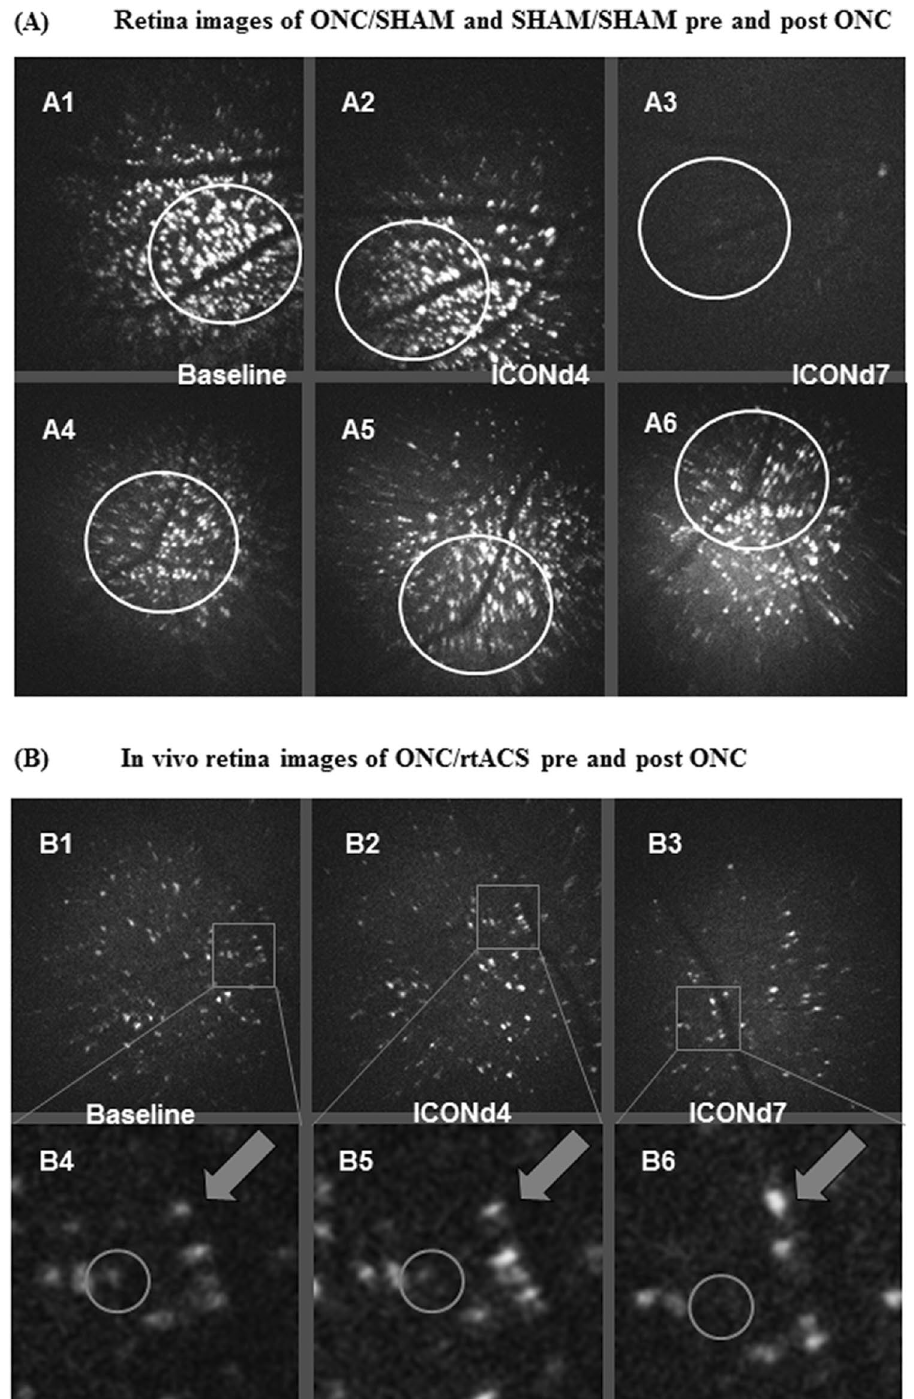
Figure 3. In vivo confocal neuroimaging (ICON) of the retina. These microphotographs demonstrate the in vivo morphological changes of retinal ganglion cells after ONC. In Fig. 3A1–A3 the preserved survival of RGCs on day 4 post ONC (A2) as compared to baseline (A1) is exemplified. The significant cell death in ONC/SHAM animals between day 4 and day 7 can be revealed when matching the images (A2) and (A3). The photomicrographs (A4), (A5) and (A6), showing the ICON results on baseline, day 4 post sham ONC, day 7 post sham ONC, indicate that in unlesioned rats no loss of RGCs developed within this period. The circles outline identical regions imaged at the different time points. Panel B displays the same region of the retina of an ONC/rtACS-treated animal, which was imaged repeatedly at several data acquisition points, i.e. before ONC (baseline; B1, B4), on day 4 (B2, B5) and day 7 post-ONC (B3, B6). The circles in the detailed images (B4), (B5), (B6) outline a single RGC with a rather weak fluorescence intensity which disappeared on day 7 after the crush. In contrast, the arrows in (B4), (B5), (B6) point to a cell which survived and which had an increased soma size at 7 days after